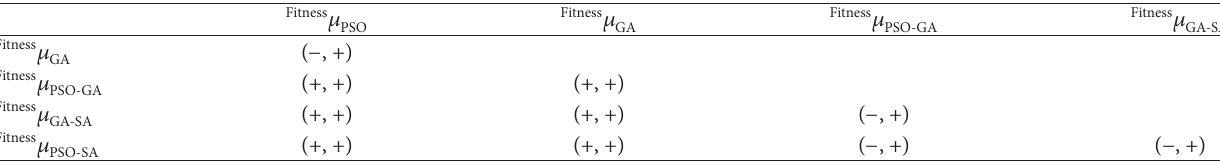
Table 5: Multiple comparison on fitness value.